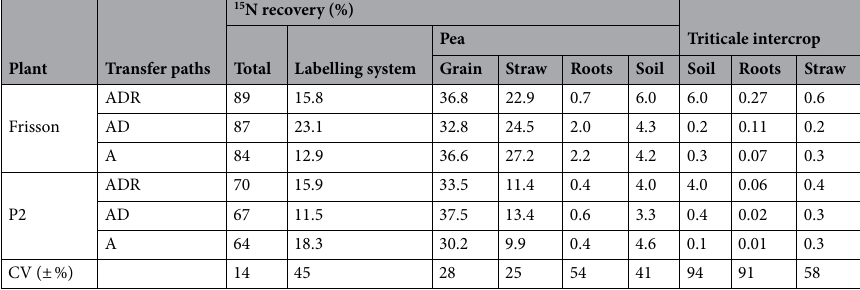
Table 1. Total 15 N recovery in the labelling systems and in pea plant parts supplied with the labelling solutions as well as in triticale plant parts as intercrop at the end of a 105-day greenhouse pot experiment; transfer paths: ADR = AMF, diffusion, and root contact between pea and intercrop; AD = AMF and diffusion; A = only AMF; CV = mean coefficient of variation between replicate pots (n =